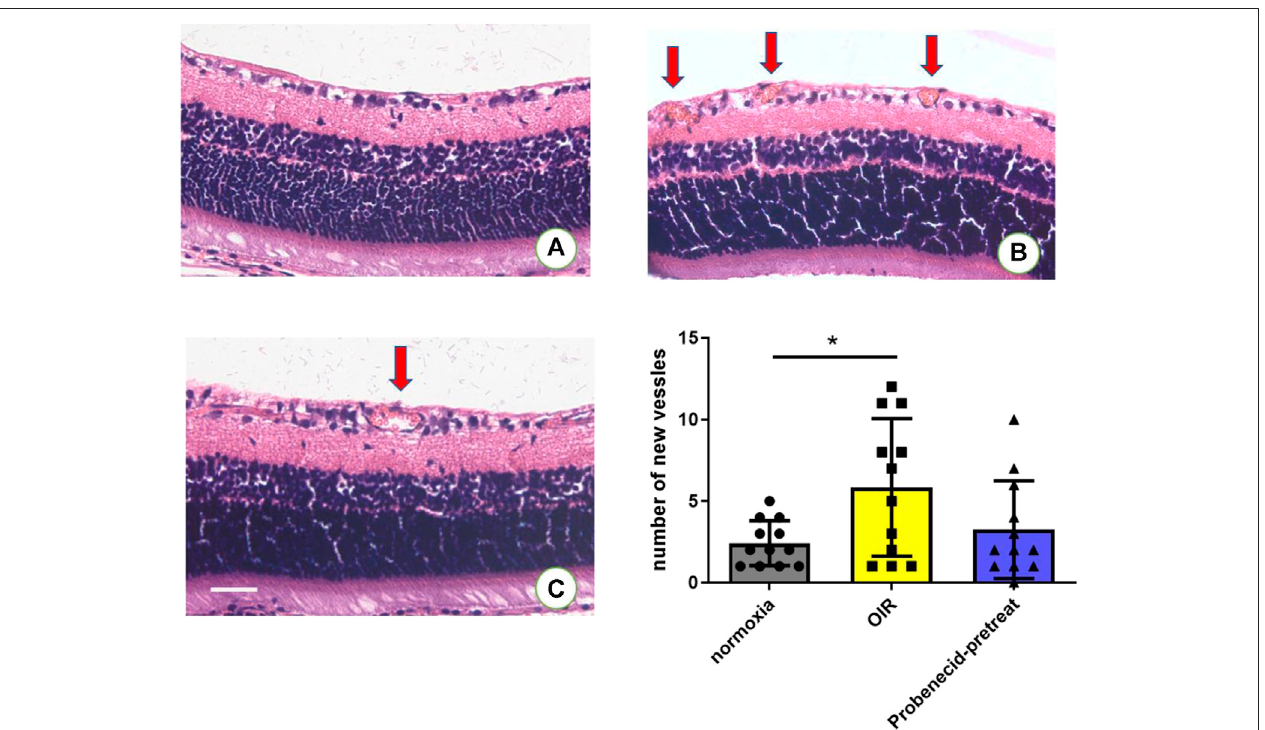
FIGURE3| ProbenecidtreatmentdiminishedretinalneovascularizationinH&E-stainedretinalsectionsin (A) normoxicgroupsand (B) OIRgroups. (C) Probenecid pretreatment was used for the retinal neovascularization analysis. No signi fi cant difference in the average number of pre-retinal vascular lesions was observed between normoxic and probenecid pretreatment retinas on P22 (n (cid:2) 12 per group). Kruskal – Wallis test. Scale bar: 20 μ m.